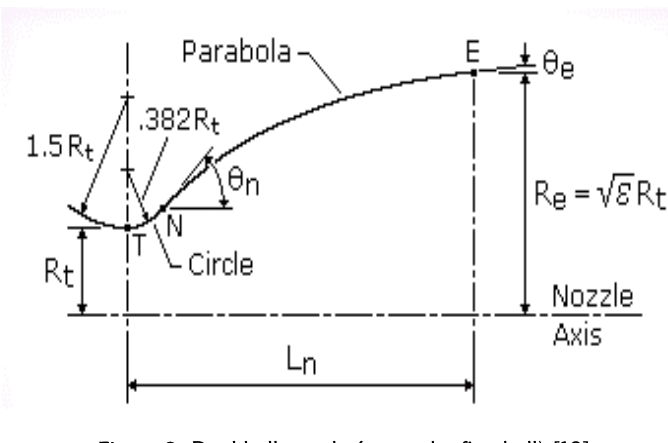
Figure 2: Dual bell nozzle (up to the first bell)